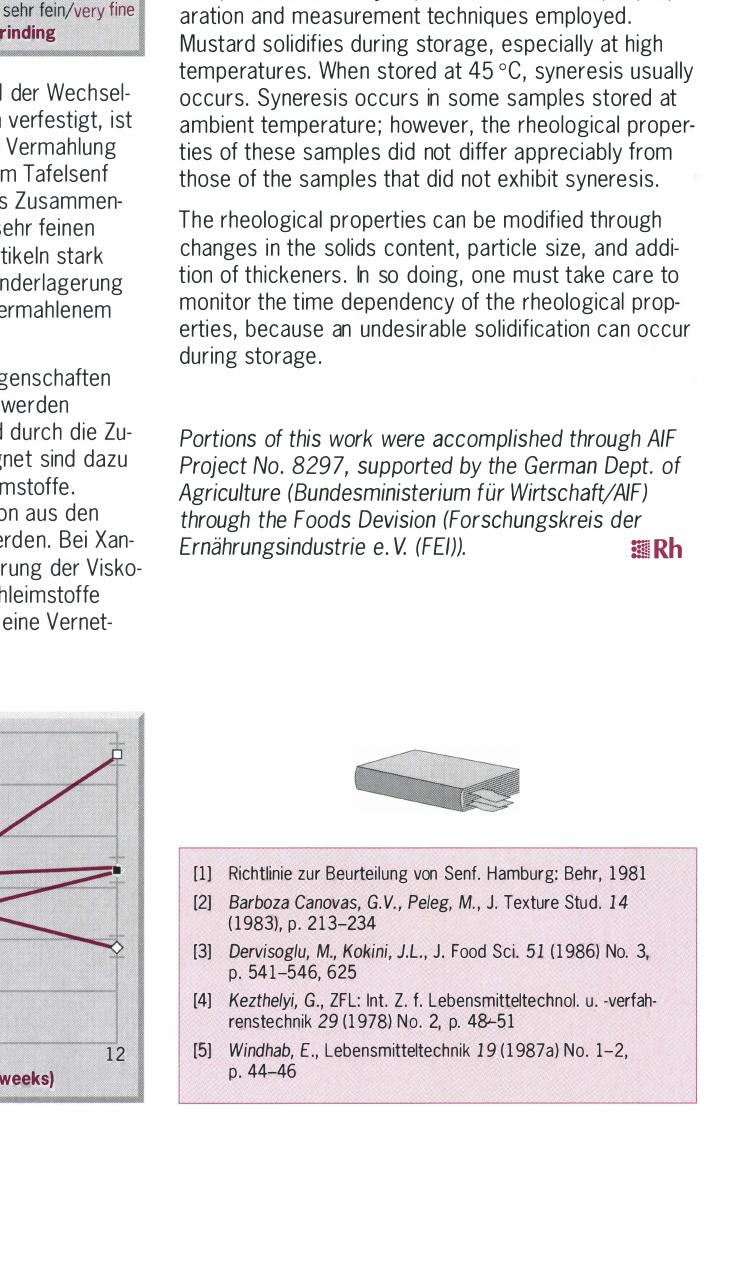
Fig. 7: The change in the yield stress values compared to the original value for various degrees of grinding. Storage temperature 25 oc =